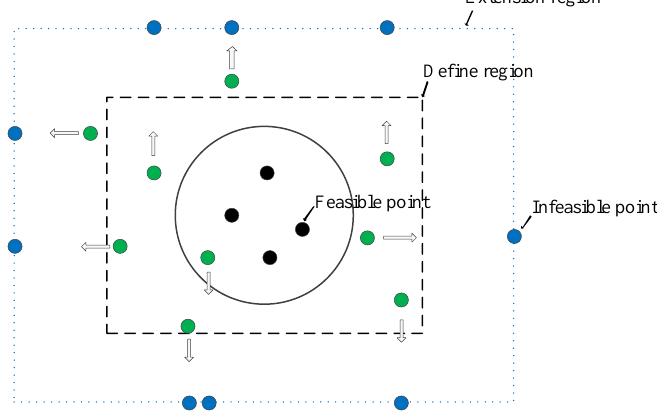
Figure 7. The distribution of point sets in the design domain.